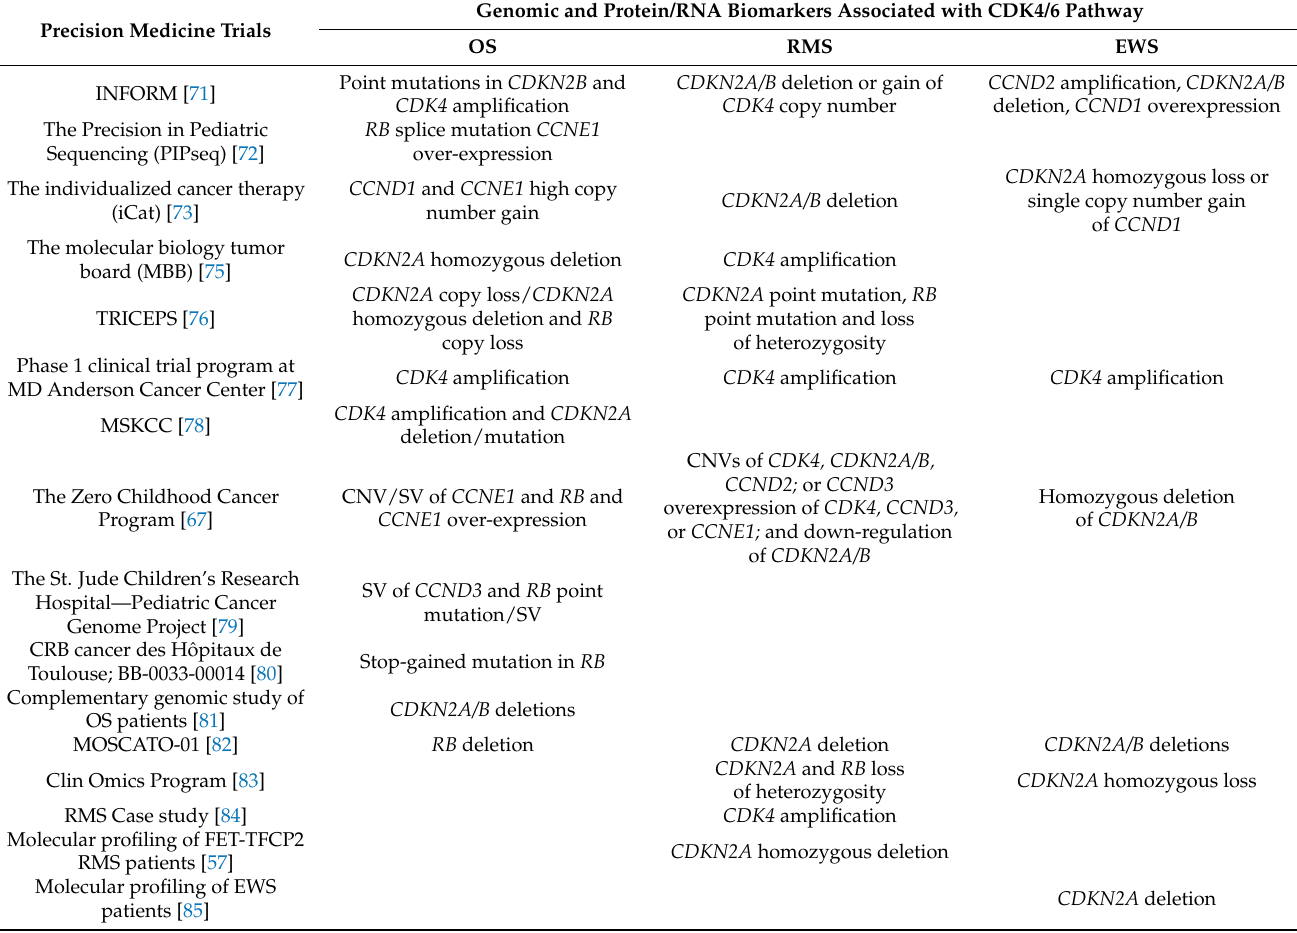
Table 1. Dysregulation of the CDK4/6 cell cycle regulatory pathway in pediatric and AYA OS, RMS and EWS